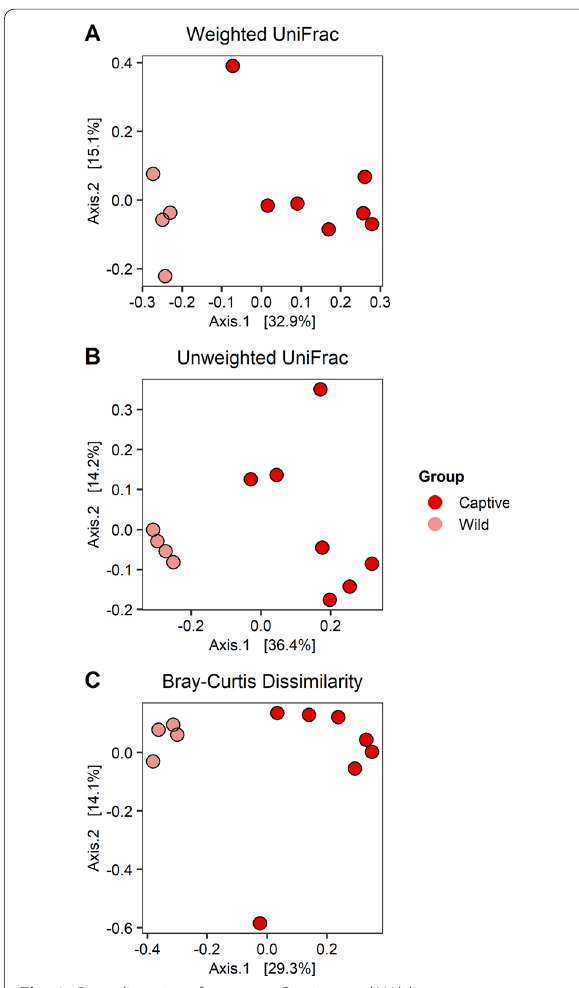
Fig. 2 Beta diversity of summer Captive and Wild mucosa microbiotas. A Weighted UniFrac, B unweighted UniFrac, and C Bray– Curtis dissimilarity are displayed on PCoA ordinations. Groups are depicted with different colors